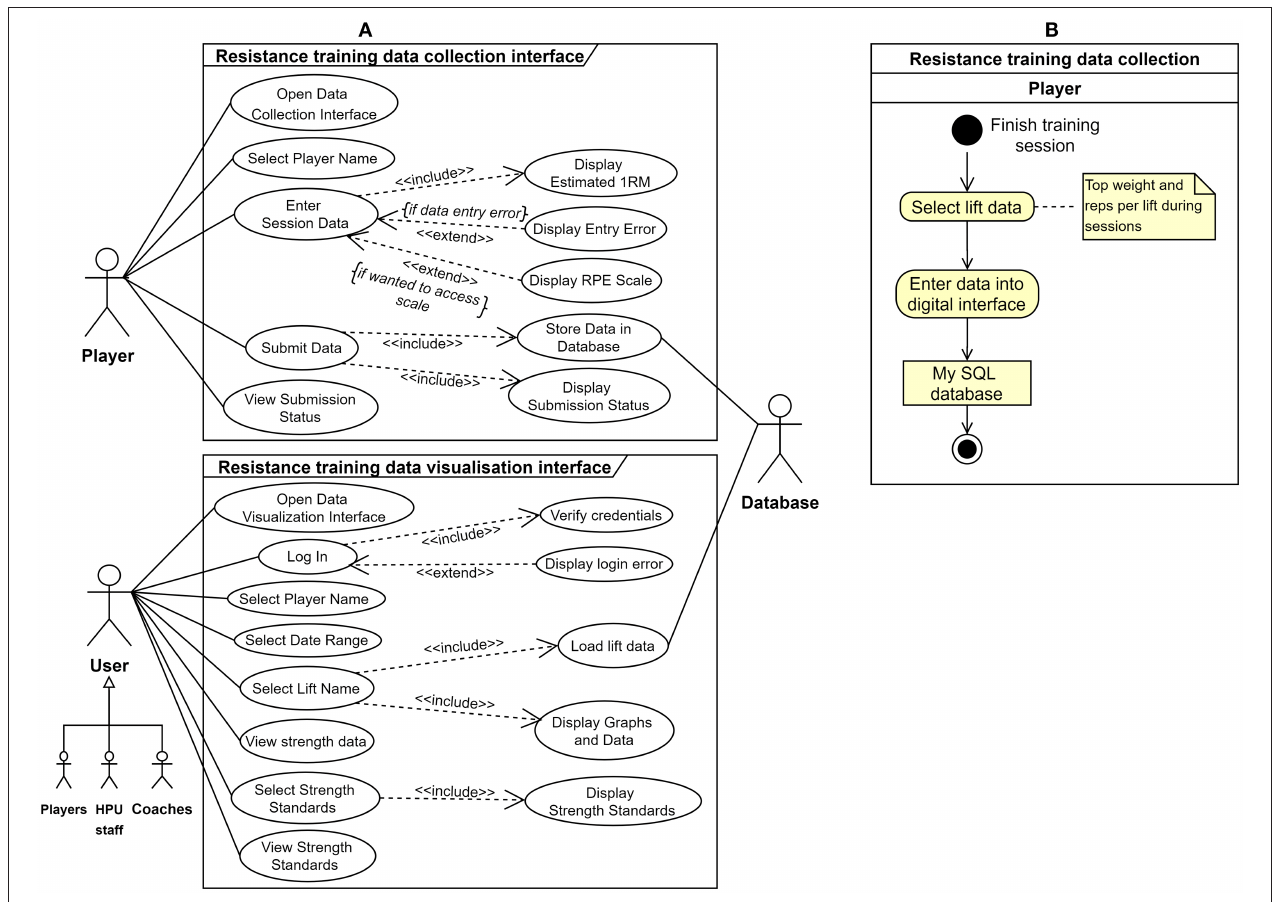
FIGURE 5 | Redesigned resistance training information flow (A) use case diagram from UML depicting the proposed system (B) resistance training data collection future state (To-Be) process model. Notice how all the activities of the S&C Coach have been eliminated (refer to Figure 2 for As-Is